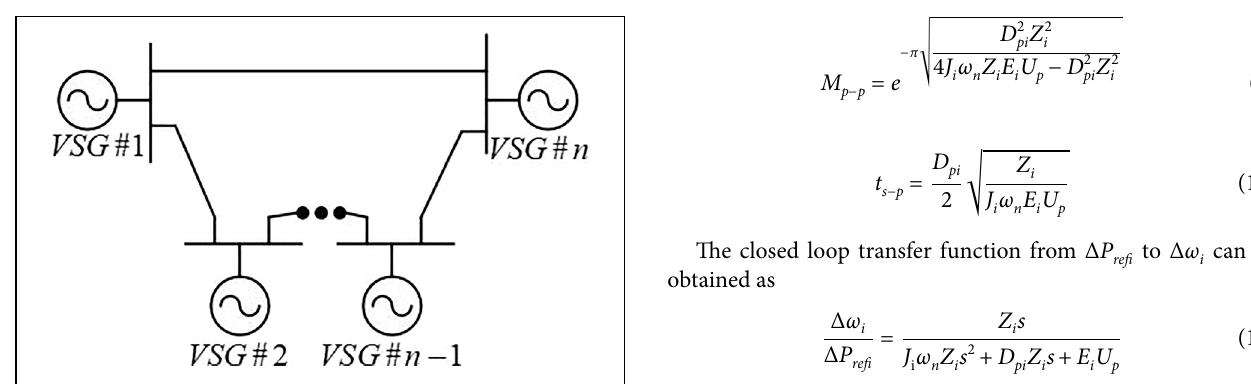
FIGURE 5 | Equivalent circuit model of networked power system.